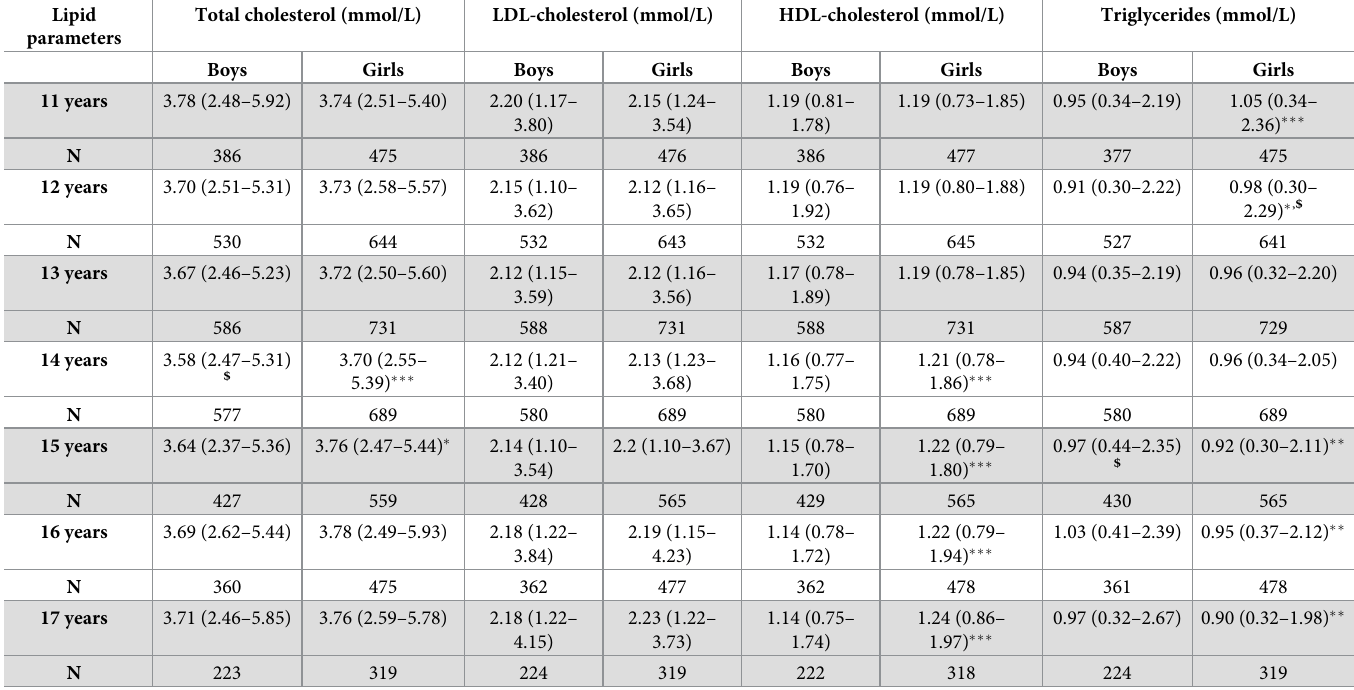
Values for biochemical parameters have been presented as Median (2.5 percentile and 97.5 percentile). N: sample number. Mann Whitney U test was used to compare difference in glycemic parameters between boys and girls of same age group and also for calculating difference between different age groups of boys and girls separately. � p � 0.01 �� p �